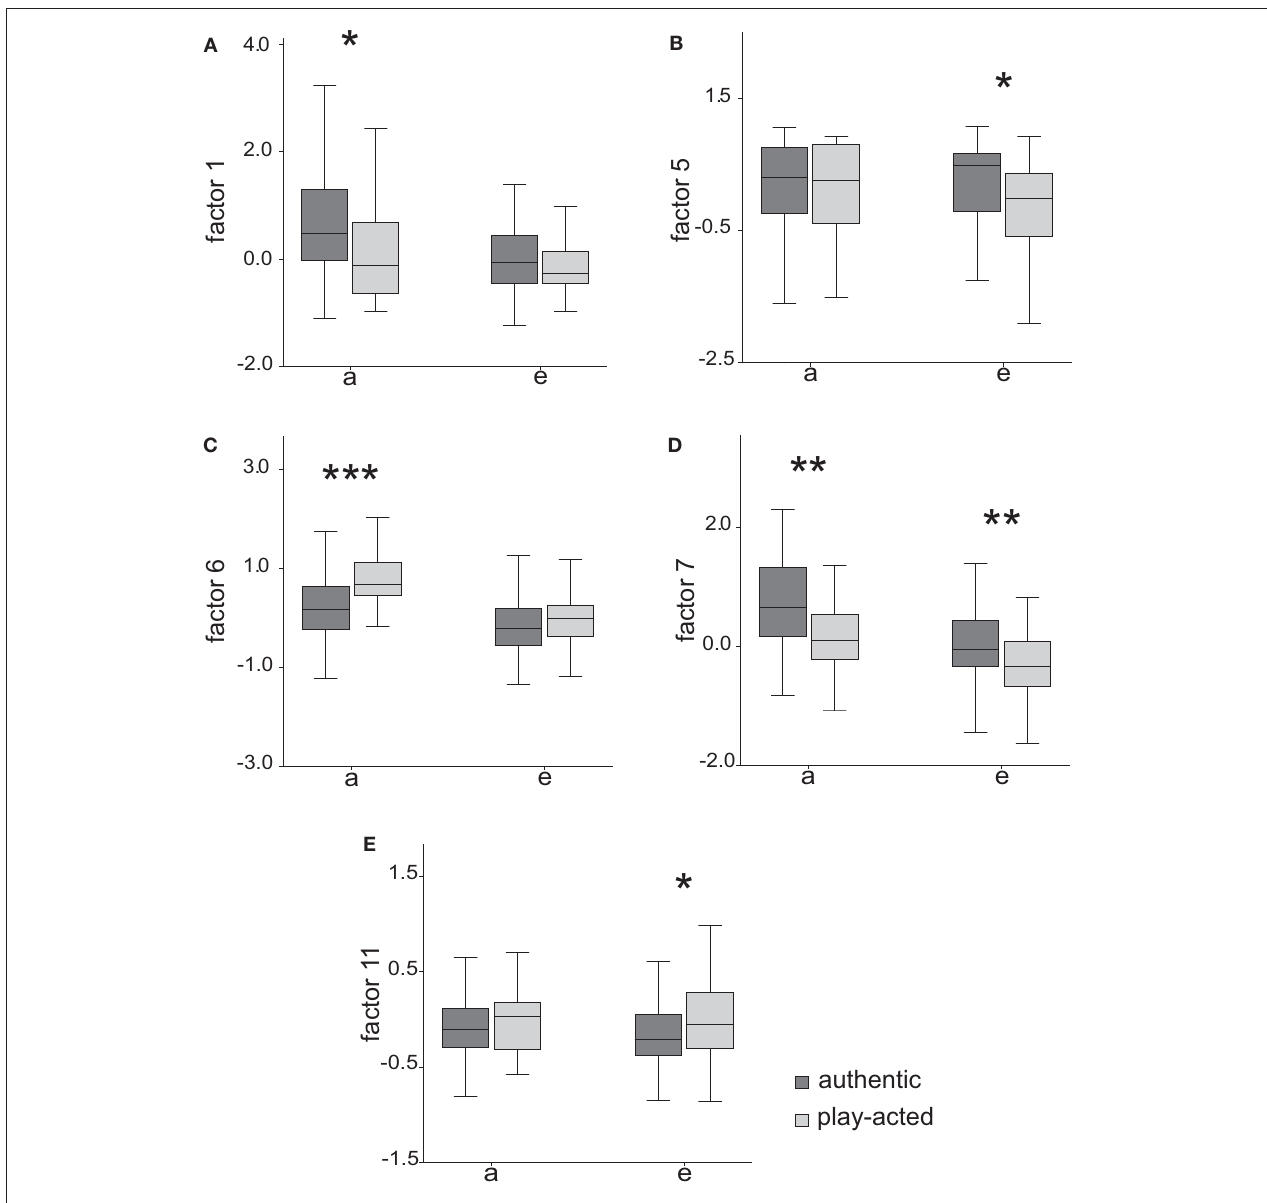
FIGURE 1 | Differences in the factor loadings between authentic and play-acted speech tokens. Given are the median, the lower, and the upper quartile. Whiskers represent the values within the 1.5 interquartile range. The